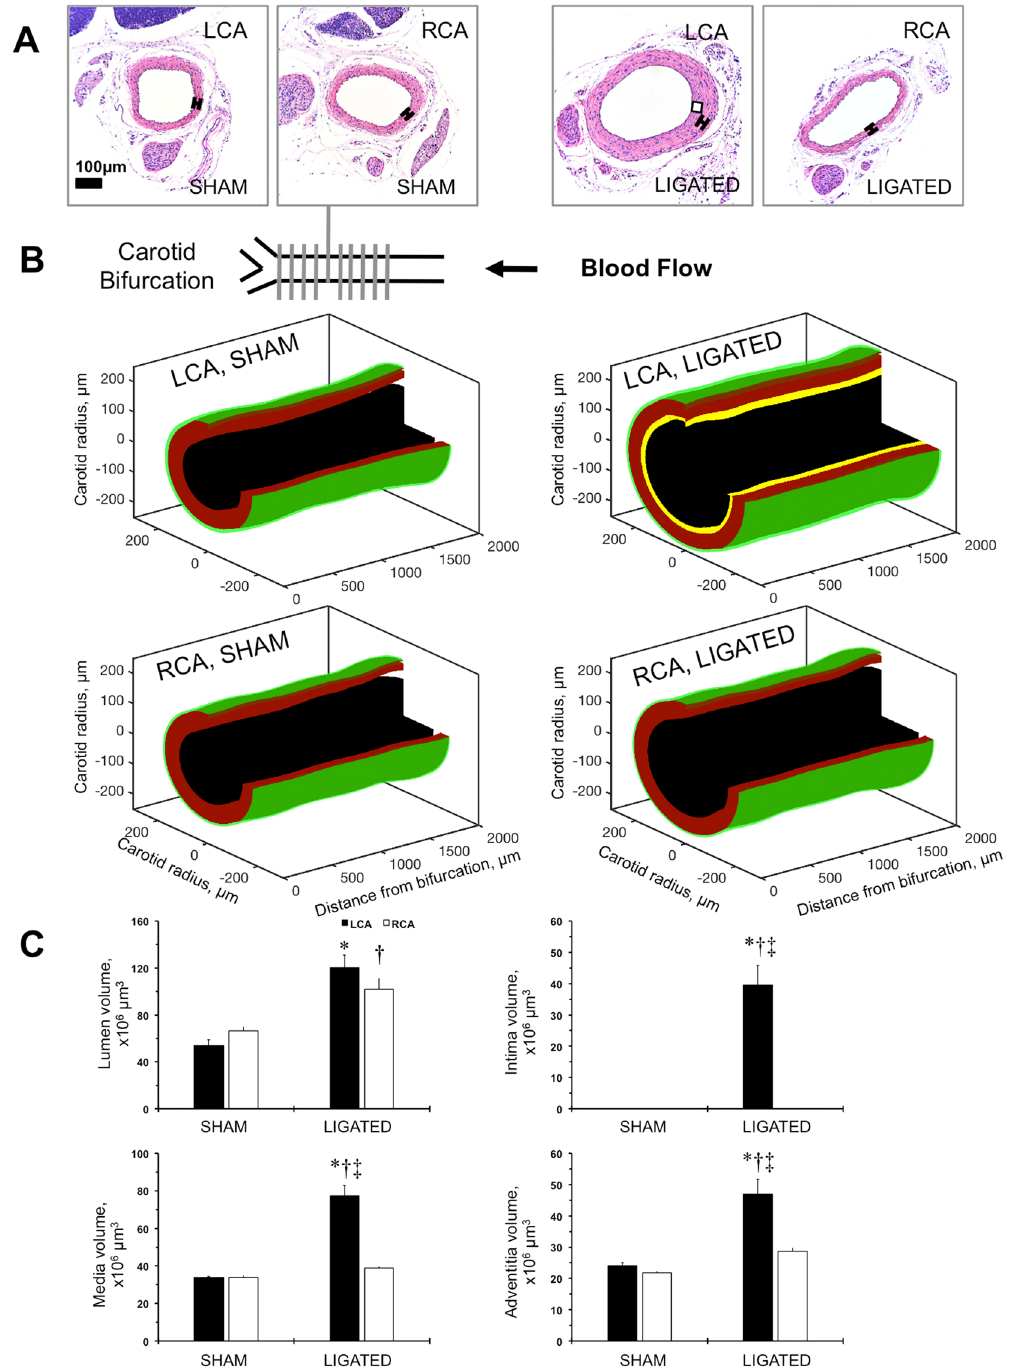
Figure 4. Reconstruction of the carotid remodeling in FVB mice after ligation. ( A ) Representative cross- sections of the left carotid artery (LCA) and right carotid artery (RCA) from sham-operated (SHAM) or ligated (LIGATED) mice. Magnification is 20x. Bar is 100 μ m. ( B ) A drawing showing carotid artery at the bifurcation point. Series of cross-sections marked with grey perpendicular lines (every 200 μ m) are covering 2,000 μ m carotid artery length. Arrow shows direction of blood flow. 3D-reconstruction of the carotid artery compartments based on series of histological sectioning. It was not possible to measure the intimal layer in non-ligated arteries. Carotid compartments are color-coded: black is lumen area, yellow is intimal area, red is medial area, and green is adventitial area. ( C) Carotid artery component volumes: lumen, intima, media, and adventitia. Black bars - LCA. Open bars - RCA. SHAM and LIGATED mice are shown on X-axis. Values are mean ± SEM. * p < 0.05 vs. LCA, SHAM; † p < 0.05 vs. RCA, SHAM. ‡ p < 0.05 vs. RCA, LIGATED. n =